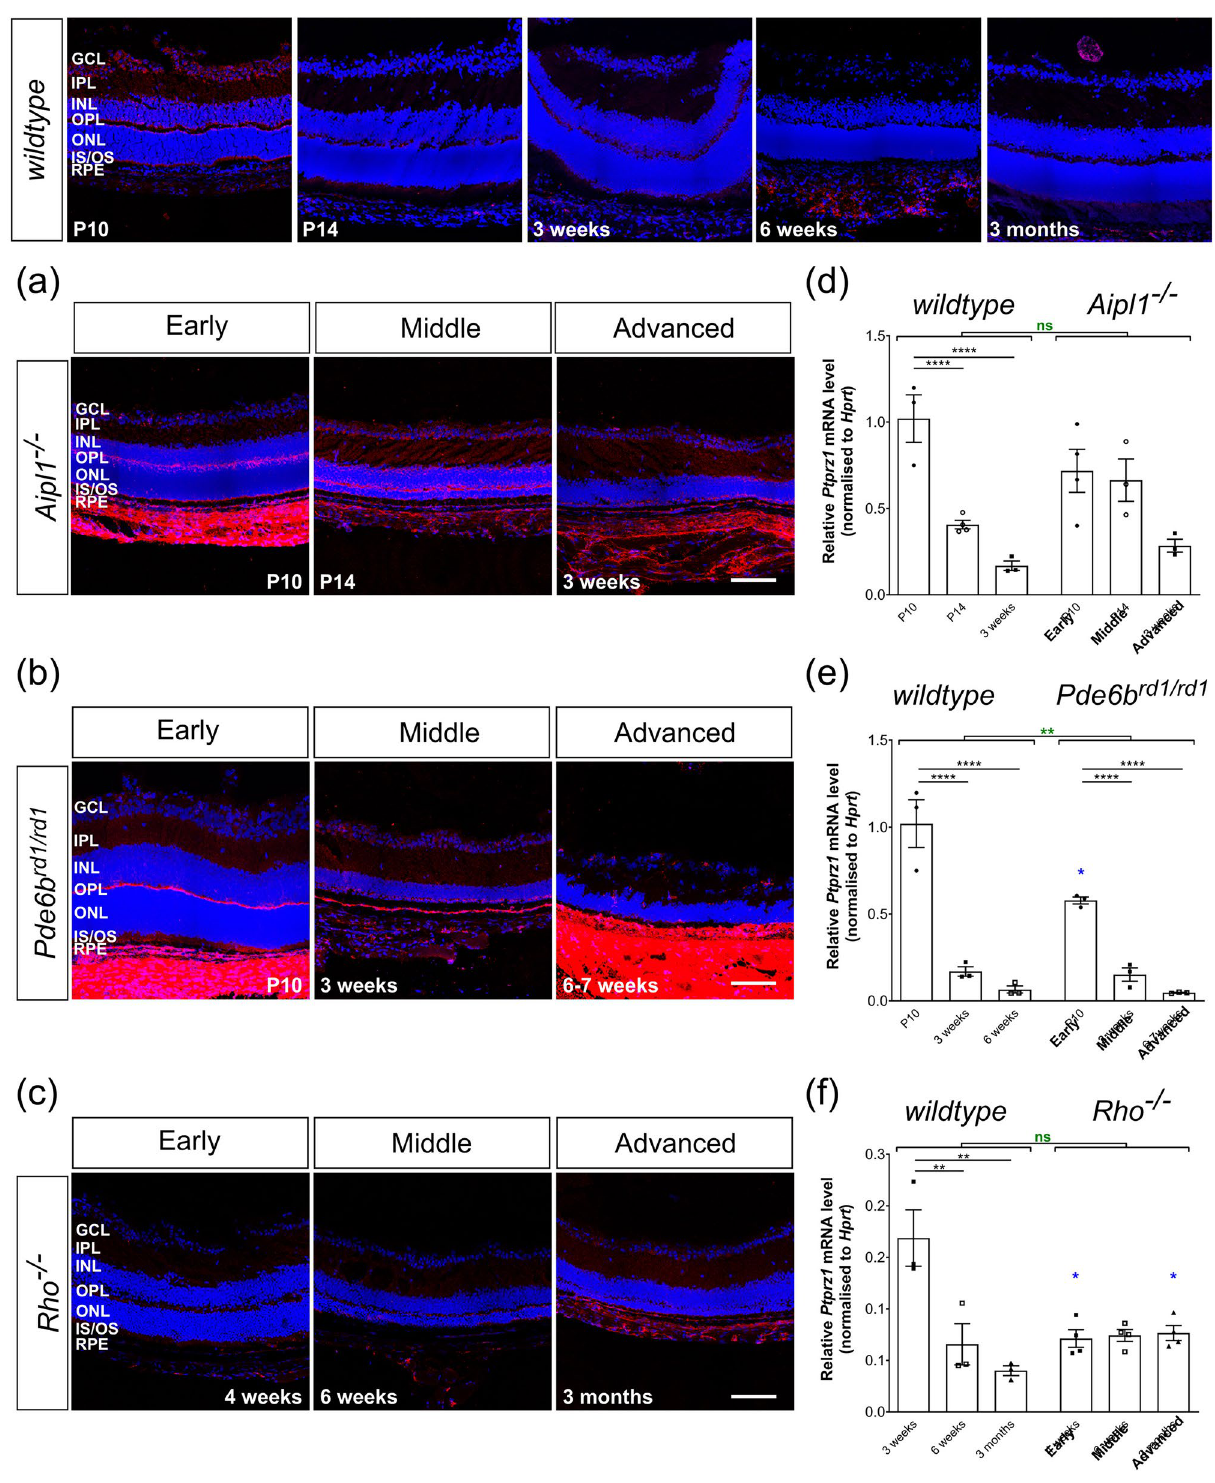
Figure 6. Phosphacan expression decreases with time and is unaffected by degeneration. ( a )–( c ) Immunolabelling for Phosphacan ( red ) was mostly restricted to GCL, IPL and OPL. In P10 wildtype, labelling was particularly evident at the outer margin of the OPL and the edge of the ONL itself. In ( a ) Aipl1 -/- and ( b ) Pde6b rd1/rd1 mice, labelling was most prominent in the OPL and RPE, compared to age-matched wildtype . ( c ) In Rho -/- retinae, labelling was weak at all time- points. ( d )–( f ) Ptprz1 mRNA expression was significantly decreased with time in all models including wildtype retinae. N.B. mRNA levels shown for wildtype are the same as in Fig. 1e. Scale bar, 100 µm. * p < 0.05, ** p < 0.01, *** p < 0.001, **** p < 0.0001 (one-way ANOVA test with Bonferroni’s correction, black ; parametric t-test for age-matched comparisons between wildtype and disease model, blue ; two-way ANOVA test applied for assessments of change over time, red ). ONL—outer nuclear layer; OPL—outer plexiform layer; INL—inner nuclear layer; IPL—inner plexiform layer; GCL—ganglion cell layer. Nuclei are counter stained with Dapi ( blue